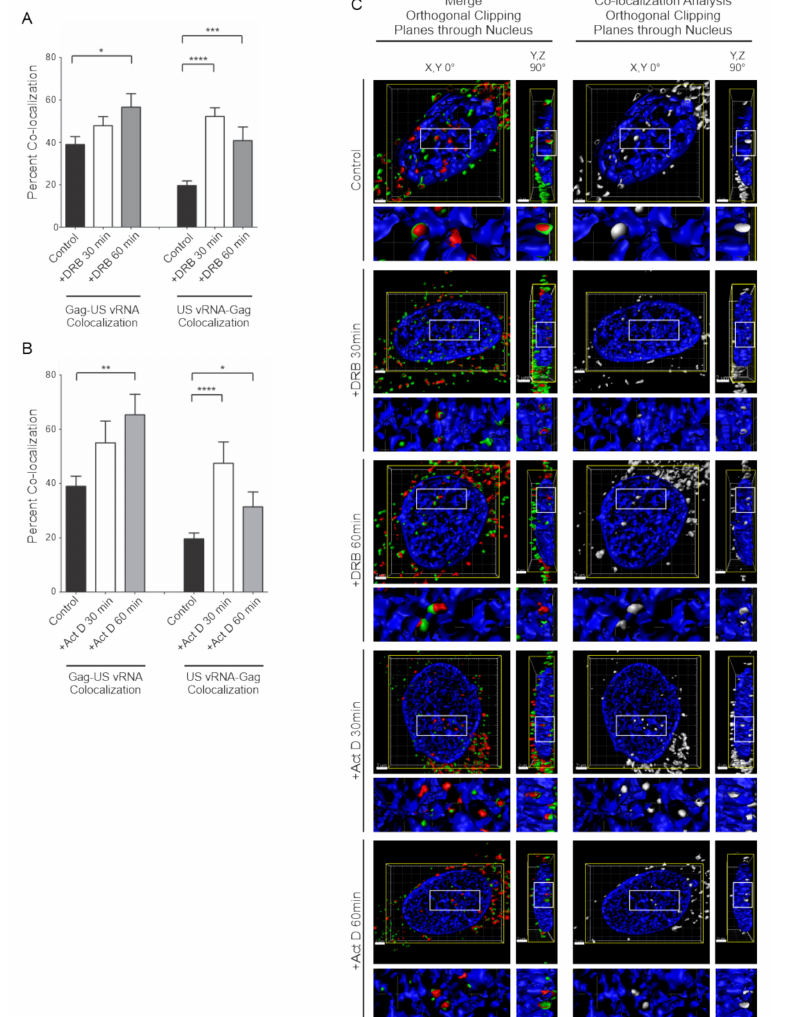
Figure 5. Transcription inhibition of HeLa HIV.Gag-GFP rtTA cells decreased the number of nuclear HIV-1 Gag and USvRNA foci but increased the degree of co-localization. Quantitative analysis of dox-induced HeLa HIV.Gag-GFP rtTA cells demonstrating the mean percent of nuclear HIV-1 Gag co-localization with USvRNA and USvRNA co-localization with HIV-1 Gag following transcription inhibition with DRB ( A ) or Act D ( B ) for 30 and 60 min compared to the untreated control. (error bars = standard error of the mean, statistical significances: * P < 0.05, ** P < 0.01, *** P < 0.001, **** P < 0.0001). ( C ) 3D surface renderings of dox-induced HeLa HIV.Gag-GFP rtTA cells depicting the co-localization (shown in white) of HIV-1 Gag-GFP (green) and USvRNA (red, detected by smFISH) foci within the nucleus (DAPI, blue) following treatment with the transcription inhibitor DRB or Act D for 30 and 60 min. 3D surface renderings were subjected to an orthogonal clipping plane to bisect the nucleus in XY or YZ planes. The white rectangle represents the region of interest enlarged